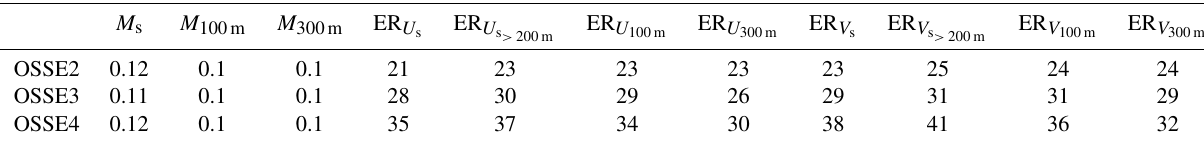
Table 7. Error reduction (ER) of the zonal ( U ) and meridional ( V ) currents, with respect to nadir altimeters only (OSSE1). Columns 1–3 represent the ocean current magnitude (ms − 1 ) averaged at the surface ( M s ), 100m ( M 100m ) and 300m ( M 300m ). Columns 4, 6 and 7 denote the error reduction in the ocean analysis considering the zonal currents at surface ( U s ), at 100m ( U 100m ) and at 300m ( U 300m ). Column 5 is the same as column 4 but excludes the shelf areas shallower than 200m ( U s ). Columns 8, 10 and 11 are the same as columns 4, 6 and > 200m